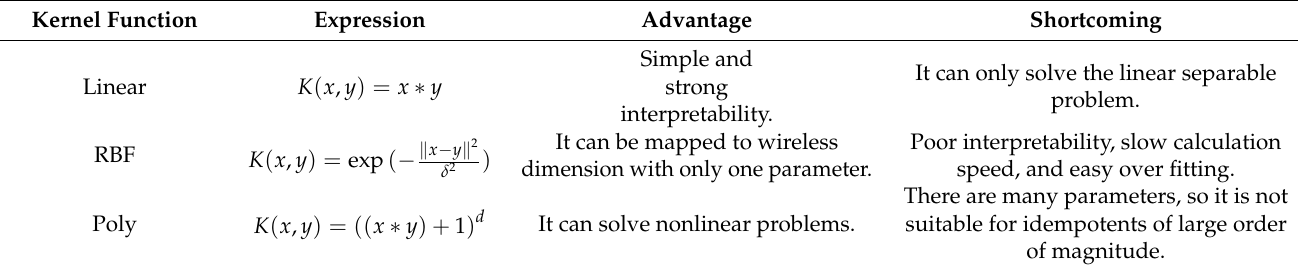
Table 2. Three common kernel